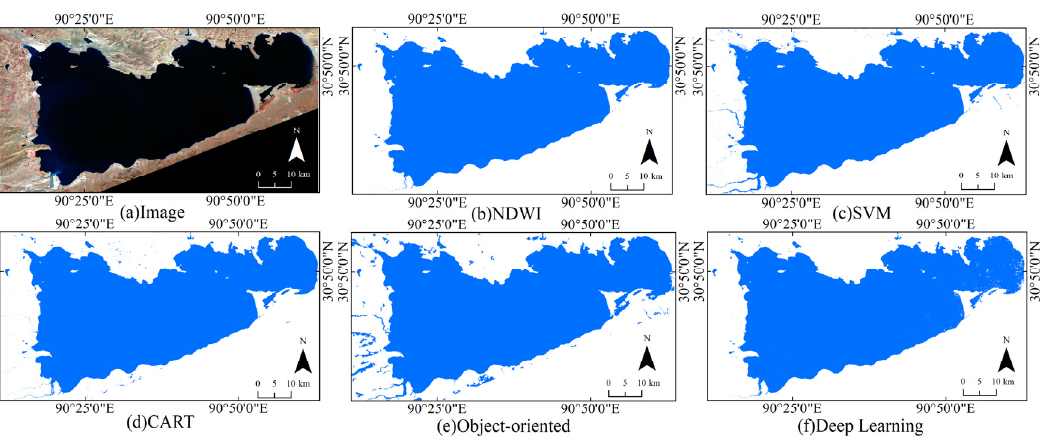
Figure 3. Water extraction results of several methods in Nam Co ( a ) original image; ( b ) NDWI; ( c ) SVM;( d ) CART; ( e ) Object-Oriented; ( f ) Deep Learning.